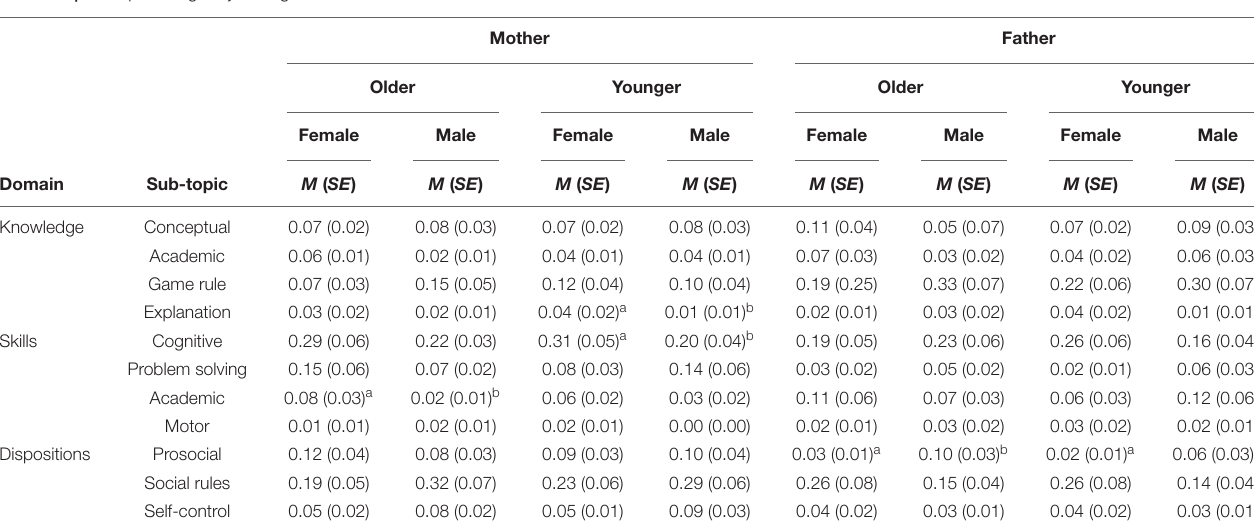
FIGURE 1 | Mother, father teaching of knowledge, skills, and dispositions. TABLE 4 | Subtopics taught by child